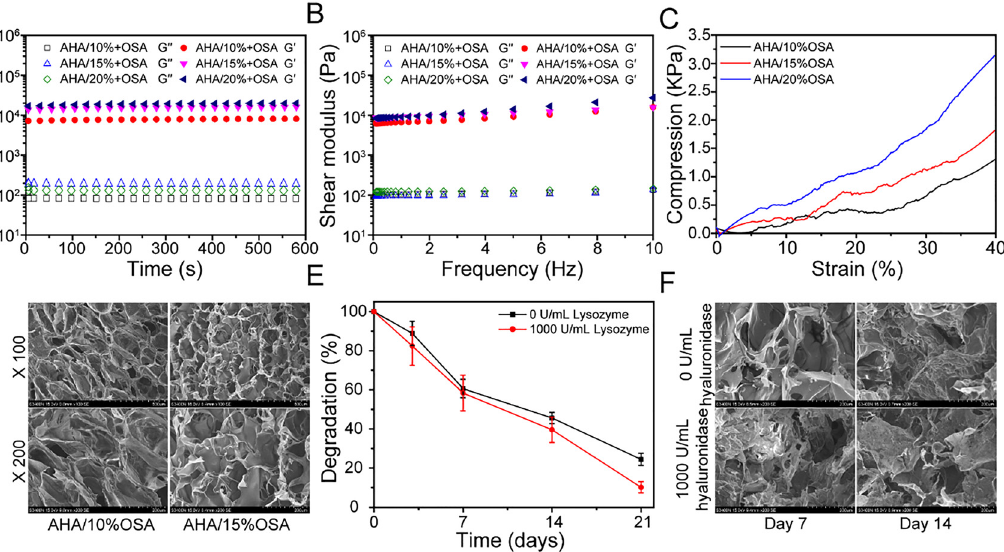
Figure 2: (A) The rheological properties. (B) The gel viscosity with frequency ranging from 0.1 to 100 Hz. (C) The compression modulus test. (D) SEM images of the cross-section of hydrogels. (E) Weight loss rate of the hydrogels in pure PBS solution and PBS solution containing 100 U mL − 1 hyaluronidase. (F) SEM images of hydrogel at different time points of